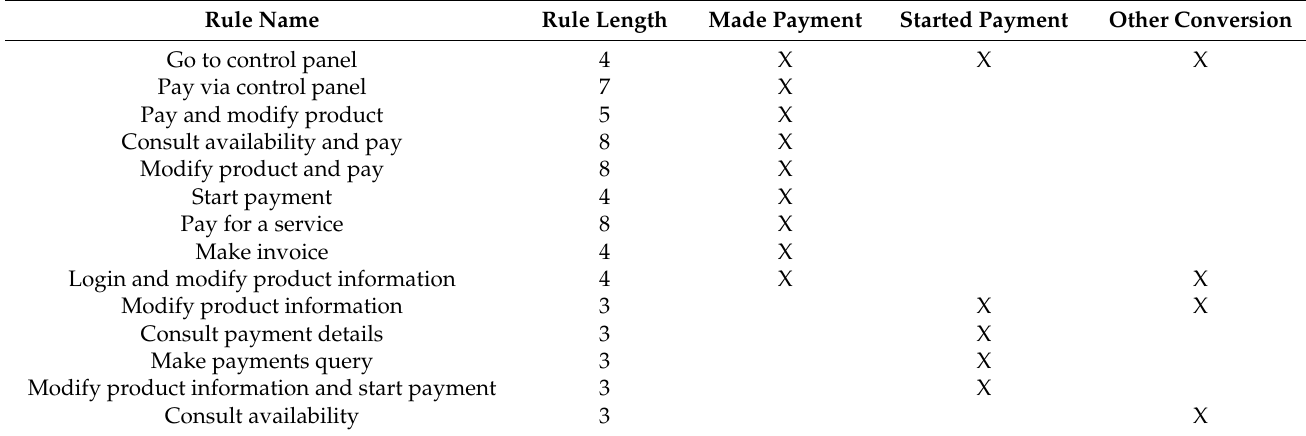
Table 5. Name of the rules found in each class of visitors. The rule length indicates the number of pages that form each rule. An “X” indicates that the rule was found in that class of